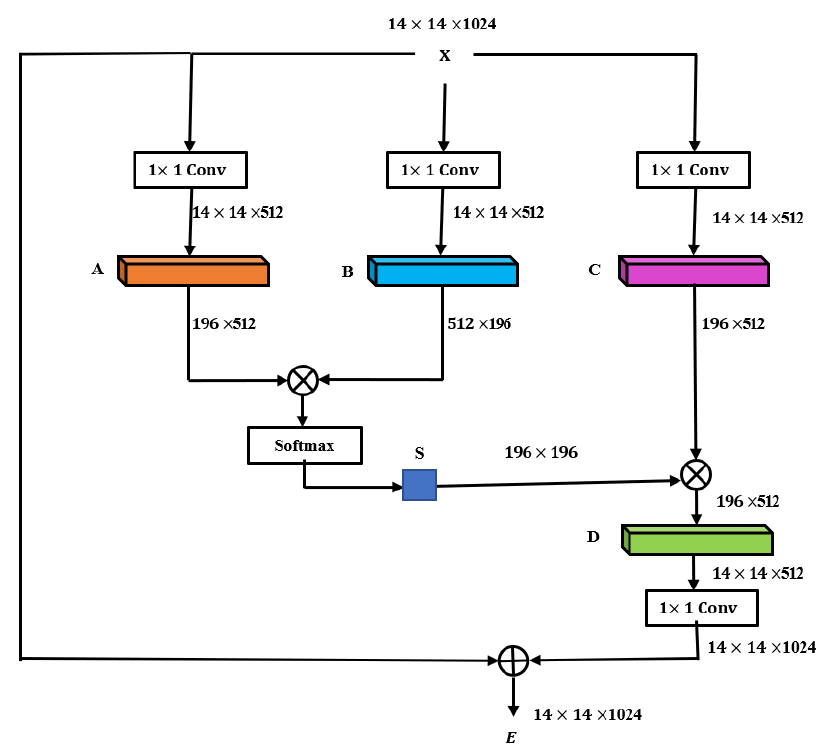
Figure 4. Non-local attention mechanism.